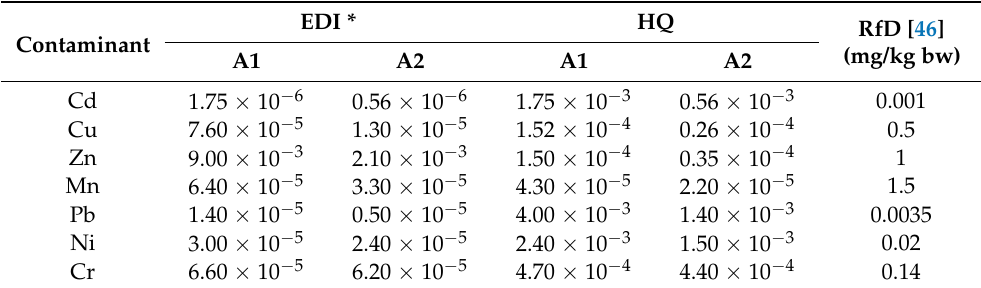
Table 16. Estimated daily intake rates and hazard quotient of metals through honey consumption in A1 area (industrial activity) and A2 area (agricultural